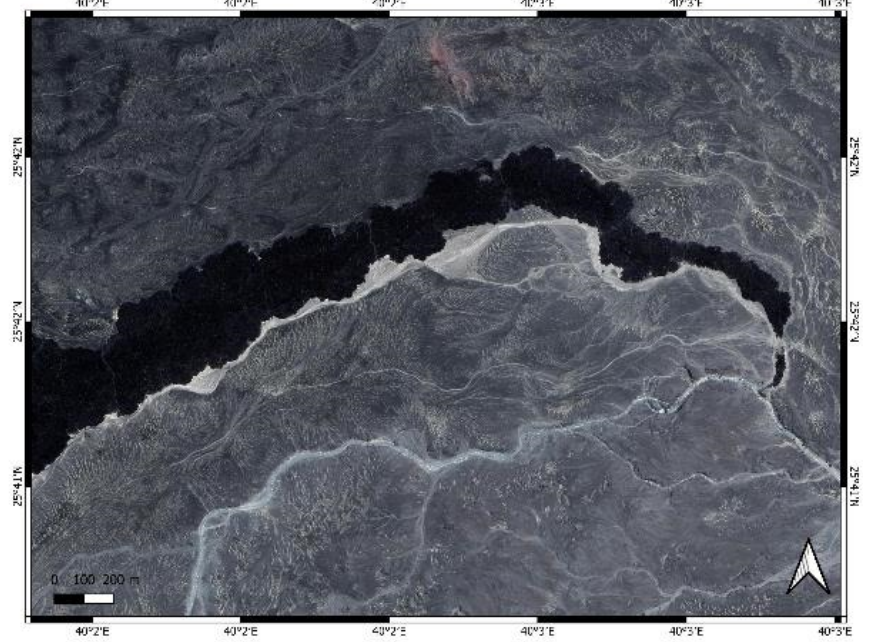
Figure 24. Gradually narrowing mass-flow-like lava flow terminus just east of the Jabal Quidr cone that was captured in a shallow wadi, similar to those visible in the Sentinel satellite image nearby. The rubbly lava flows show remarkably uniform flat tops within which only few larger blocks are noted (Figure 25). Pressure ridges can be recognized as a reflection of the movement of the flow body gradually forced to remain in the shallow valleys (Figure 25).